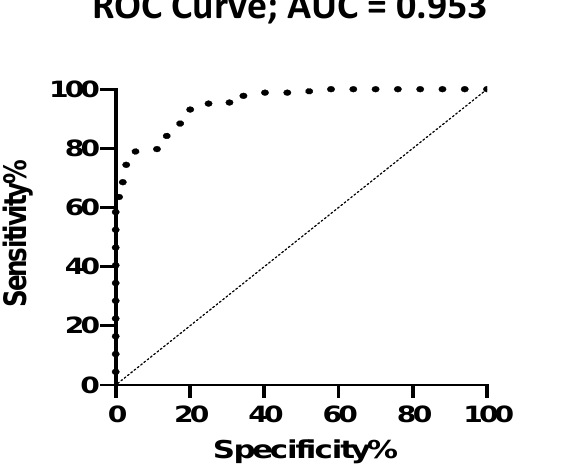
Figure 3. ROC curves and AUC for estimating the best differentiating accuracy of the microangiopathy evaluation score.